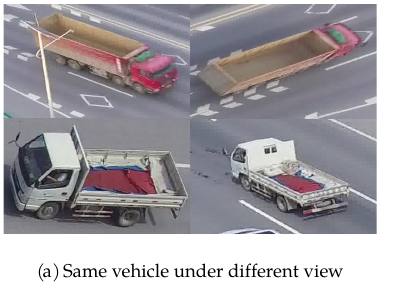
Figure 3. Intra-class variation and inter-class similarity in the vehicle ReID